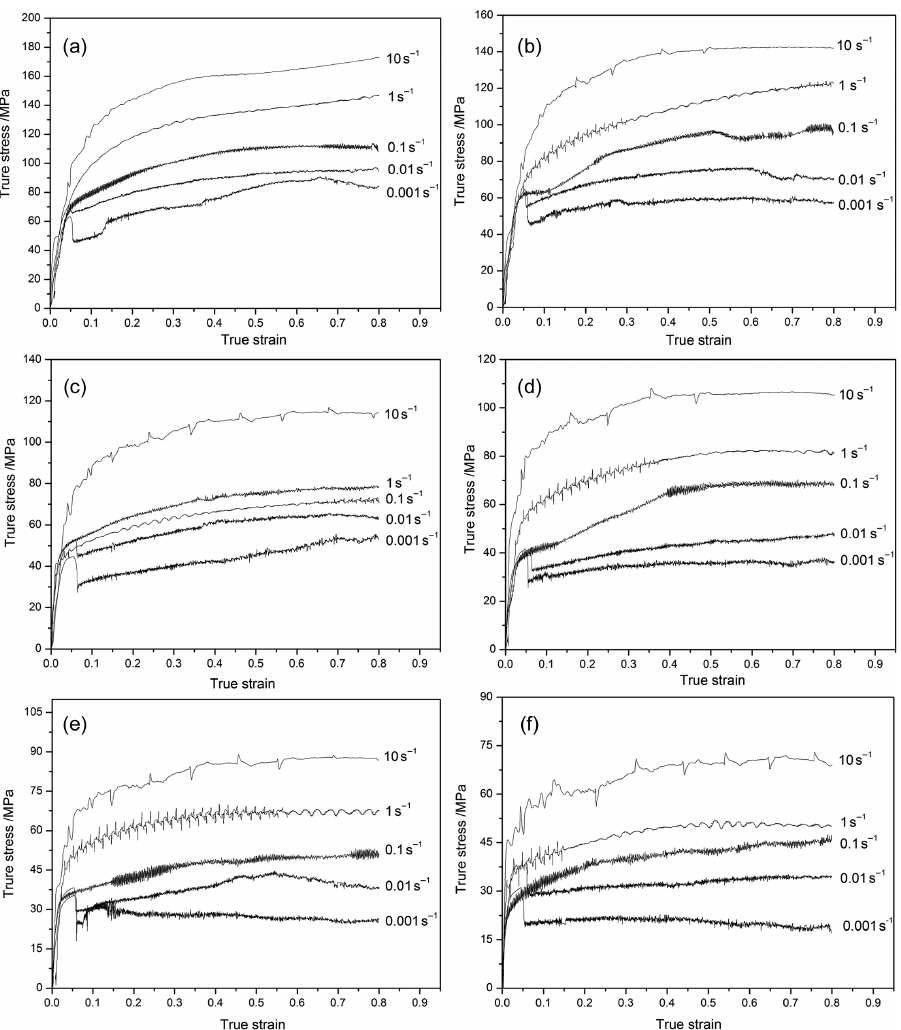
Figure 2: Flow curves of BFe10-1-2 alloy at various strain rates with temperatures of: (a) 1,023 K, (b) 1,073 K, (c) 1,123 K, (d) 1,173 K, (e) 1,223 K, (f) 1,273